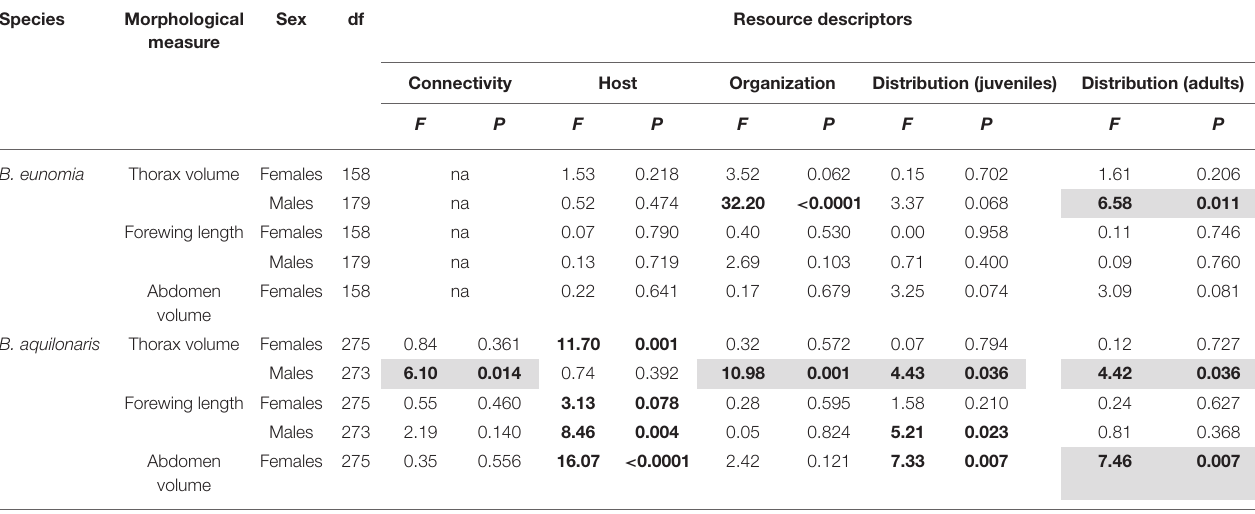
TABLE 4 | Relationship between habitat quality and adult morphology in males and females of both B. eunomia and B. aquilonaris . Species Morphological